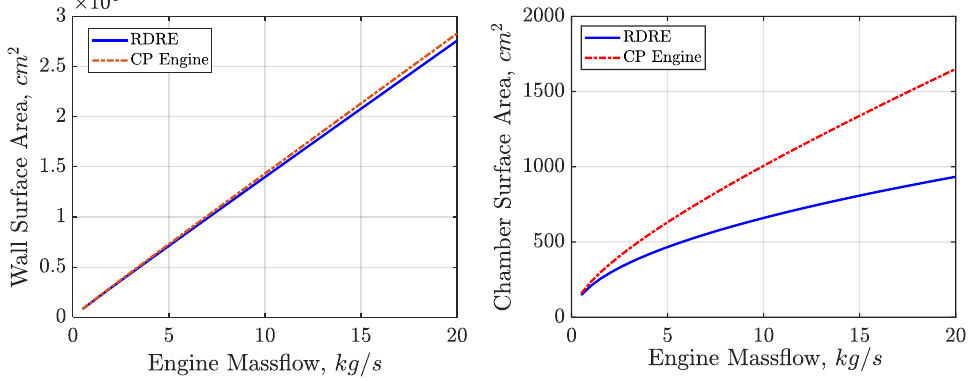
Figure 6. Surface area comparison. (l) total surface area. (r) chamber surface area.